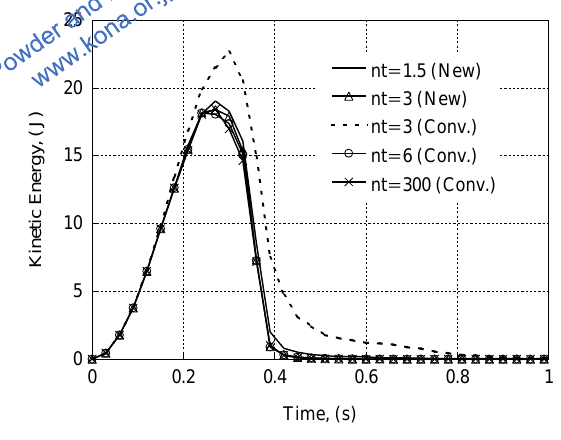
Kinetic energy of total particles in packing simulation